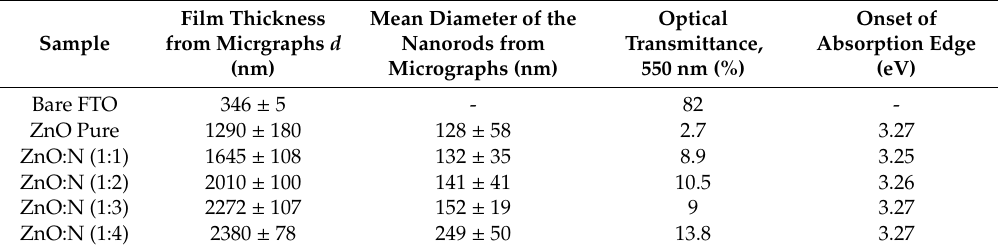
Figure 2. ( a ) Mean diameter and dispersion of the ZnO NRs; ( b ) Surface area calculated by equation (1) and number of NRs counted on different 5 × 5 μ m 2 squares at the sample surface. Table 1. Summary of results: ( a ) thickness of the films (estimated from cross-sectional SEM images shown in Figure S2); ( b ) mean NR diameter (obtained from SEM images); ( c ) optical transmittance at 550 nm; and ( d ) Onset of absorption edge as extracted from the extrapolation of the linear part of the absorption spectra (for further details see Figures S2 and S3 in supplementary information).